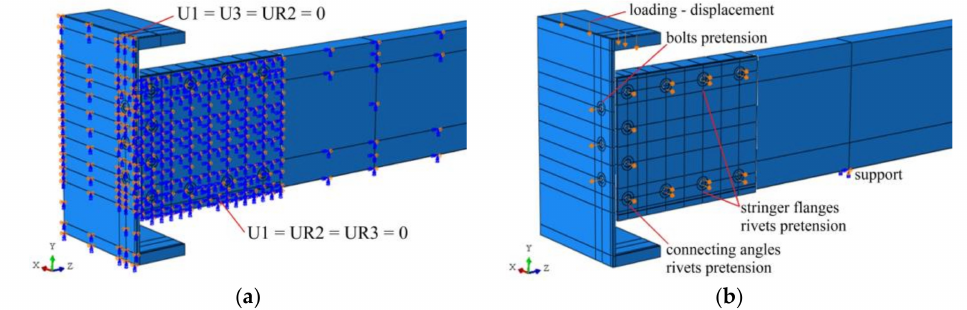
Figure 10. Boundary conditions of the connection model. ( a ) Anti-symmetry and symmetry boundary conditions. ( b ) Support, loading and pretension of rivets and